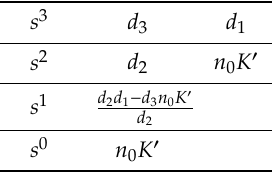
Table 1. Routh table established according to Equation (4).